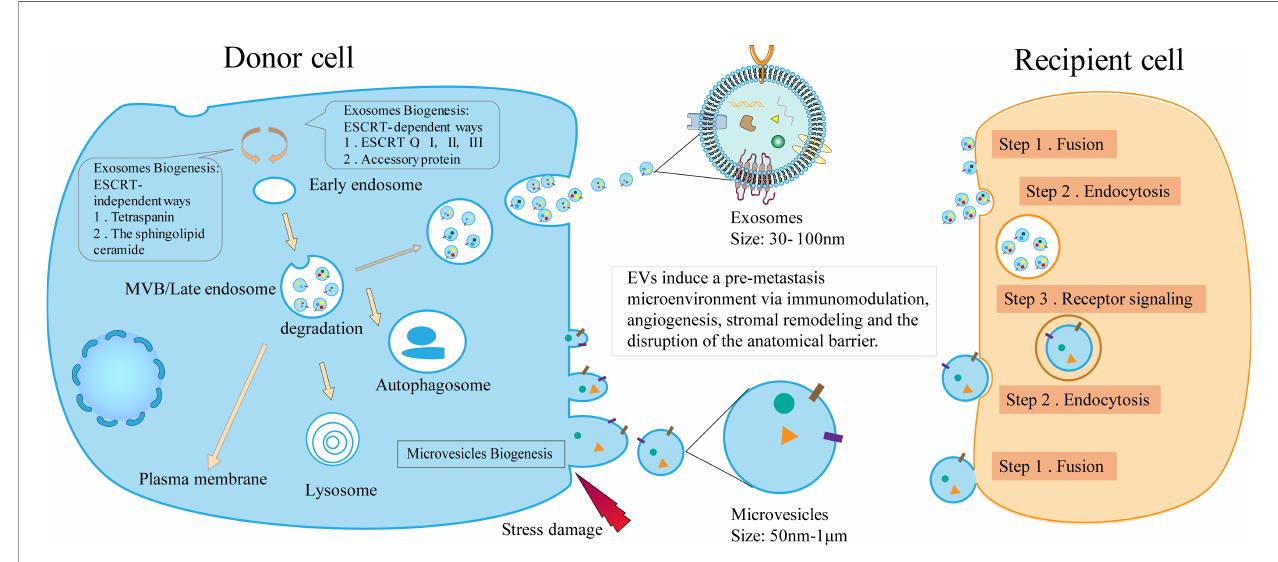
FIGURE 1 | The biogenesis of EVs and the mechanism of the formation of pre-metastasis microenvironment. The biogenesis of EVs includes the occurrence of exosomes and microvesicles. By acting as communicators between donor and recipient cells, EVs induce immunomodulation, angiogenesis, stromal remodeling, and barrier disruption, ultimately contributing to the pre-metastasis